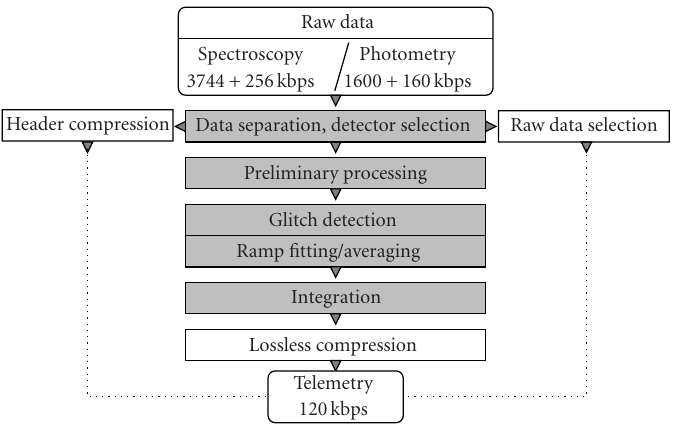
Figure 3: A schematic diagram for on-board processing concept. (Dark grey color indicates the modules where raw data are lossy com-